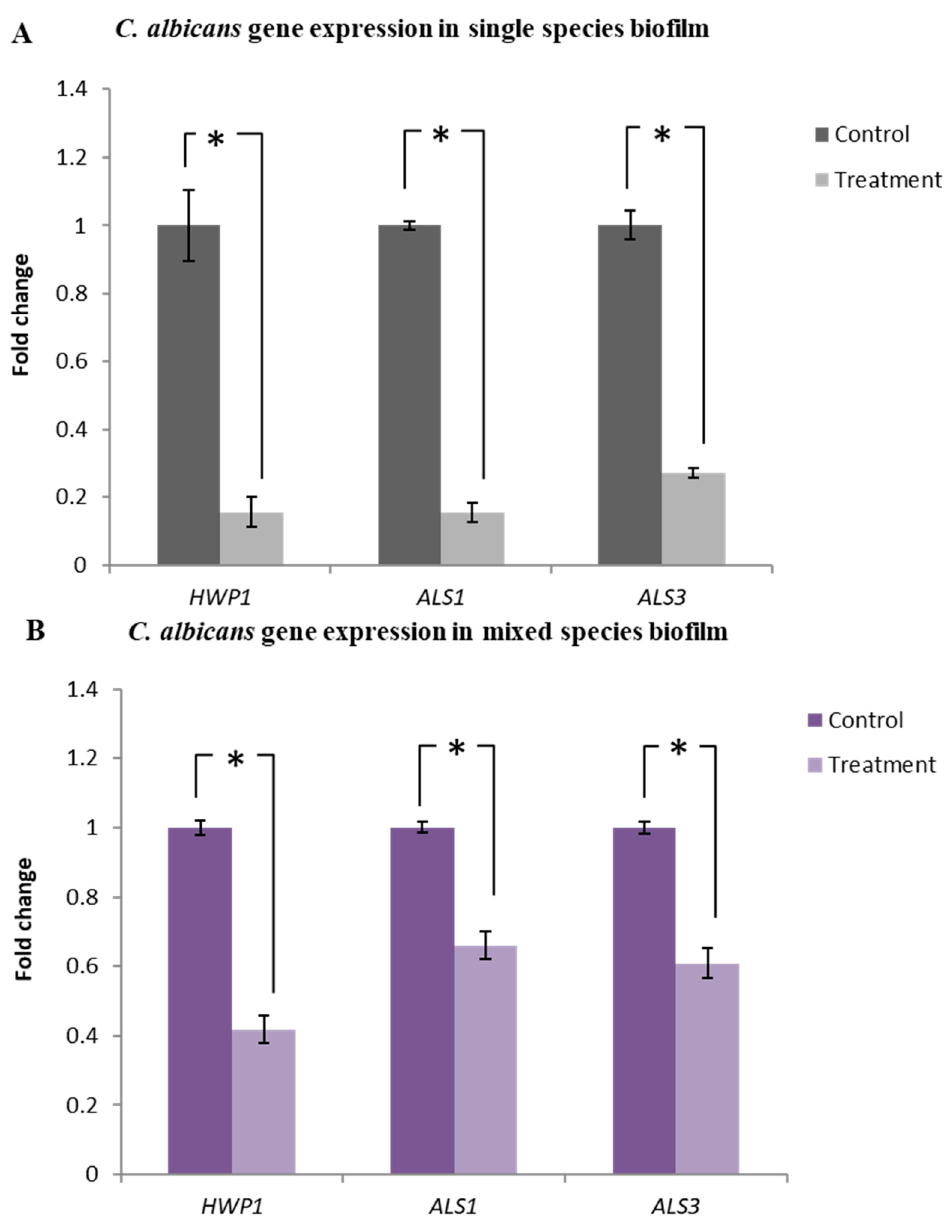
Figure 7. Lactobacillus plantarum 108 supernatant down ‐ regulated the expression of HWP1, ALS1 and ALS3 genes in Candida albicans single and mixed ‐ species biofilms. Quantitative PCR helped to evaluate the expression of HWP1, ALS1 and ALS3 genes in C. albicans ( A ) single and ( B ) mixed species biofilms treated with Lp108 supernatant. Target genes in samples were normalized with the C. albicans housekeeping gene PMA1 .The graphs show the relative expression fold change of treated group with respect to the control group. In the presence of supernatant, expression of hyphal growth associated genes were significantly down ‐ regulated in both single and mixed ‐ species biofilms. Data represent the mean ± SD of three independent experiments and statistical significance (*) with respect to control group ( p < group ( p < 0.05).